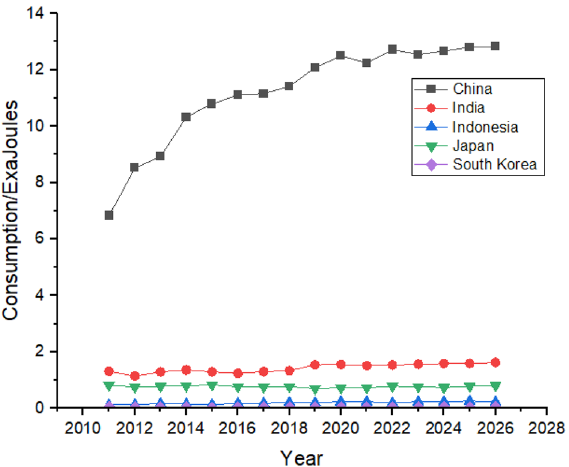
Figure 16. Hydroelectricity consumption in Asian